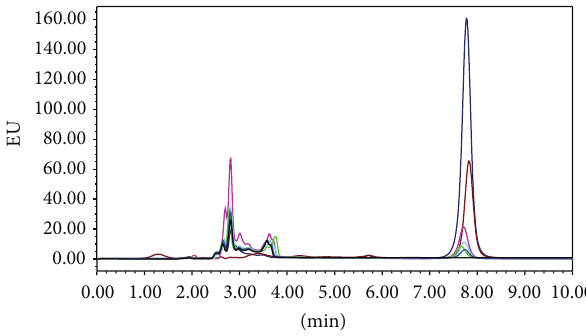
Figure 1: HPLC chromatogram of AFB 1 (5ng/mL) after incubation with different percentages of MRS at 25 ∘ C for 30 min.